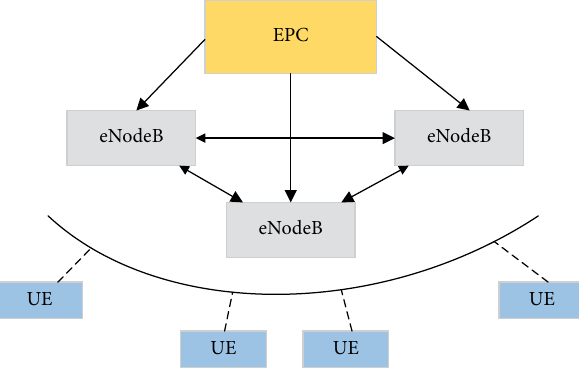
Figure 4: Architecture of